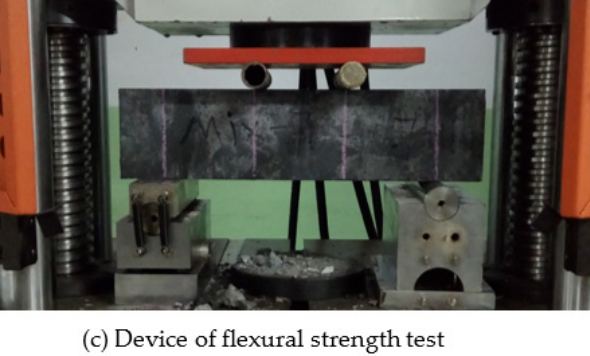
Figure 3. Device used for mechanical properties test.